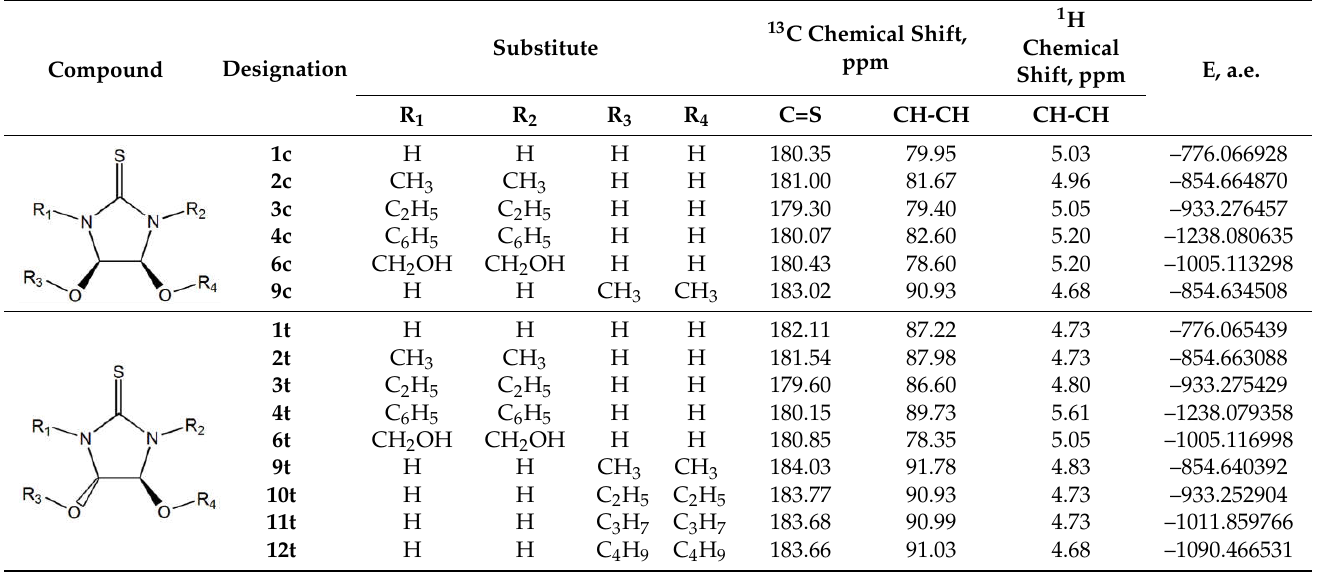
Table 1. Chemical shifts for carbon and hydrogen atoms of the imidazolidine-2-thione ring and energies for cis and trans derivatives of DHIT.